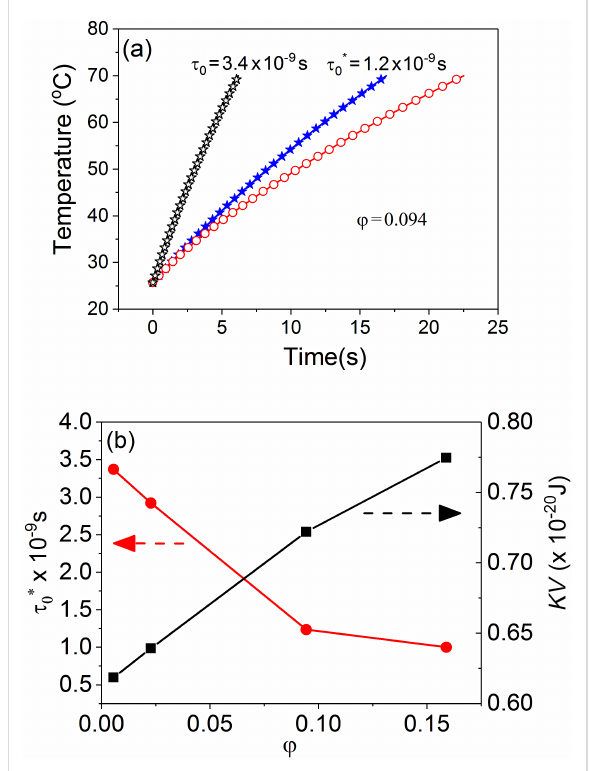
Figure 1: (a) Red open circles – adiabatic curve obtained by a proper experimental methodology in the case of a ferrofluid with φ = 0.094, black open stars – theoretical curve obtained from the Rosensweig model with input parameters specific to the ferrofluid with φ = 0.094 (e.g., KV = 7.2 × 10 − 20 and H 0 = 21 kA/m), but considering for the re- laxation time constant the value obtained from a more diluted sample ( τ 0 = 3.4 × 10 − 9 s, φ = 0.005), filled blue stars – the same theoretical curve adjusted to τ 0 at 1.2 × 10 − 9 s for the best fit of the adiabatic curve. (b) Volume fraction dependence of τ 0 * and anisotropy energy barrier ( Δ E *) as experimentally